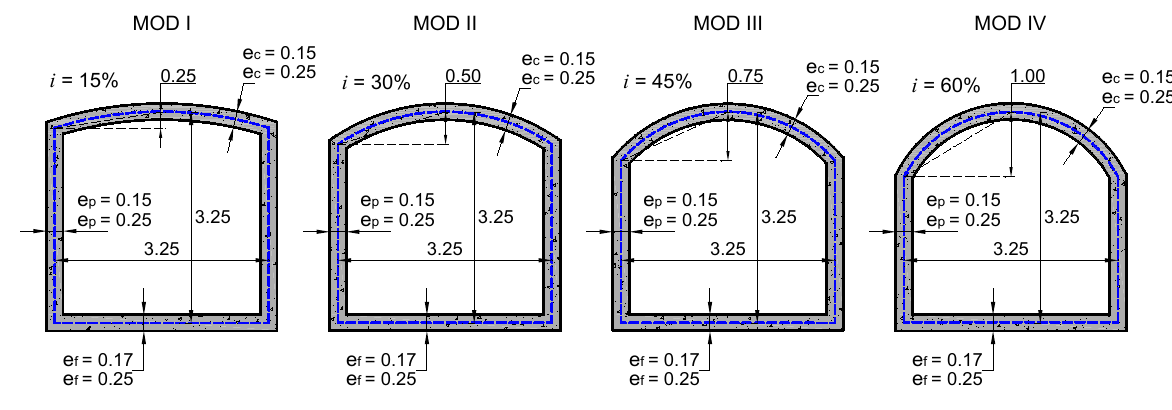
Figure 5. Representation of the cross section of the modified culverts.